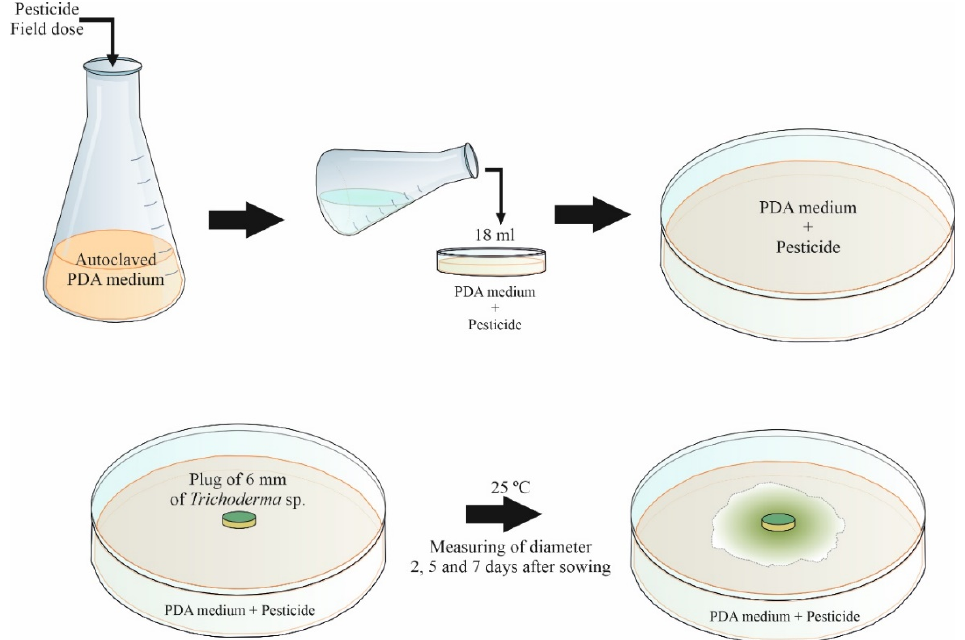
Figure 1. Evaluation of the effect of pesticides in the development of autochthonous Trichoderma strains.